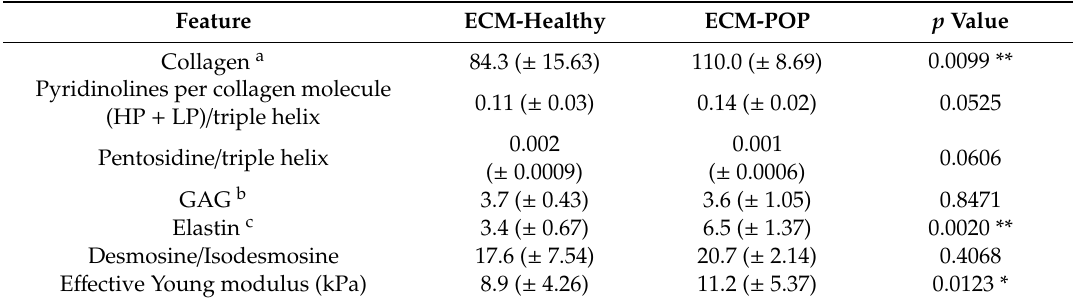
Table 1. Biomechanical and biochemical characterization of vaginal extracellular matrix (ECM).